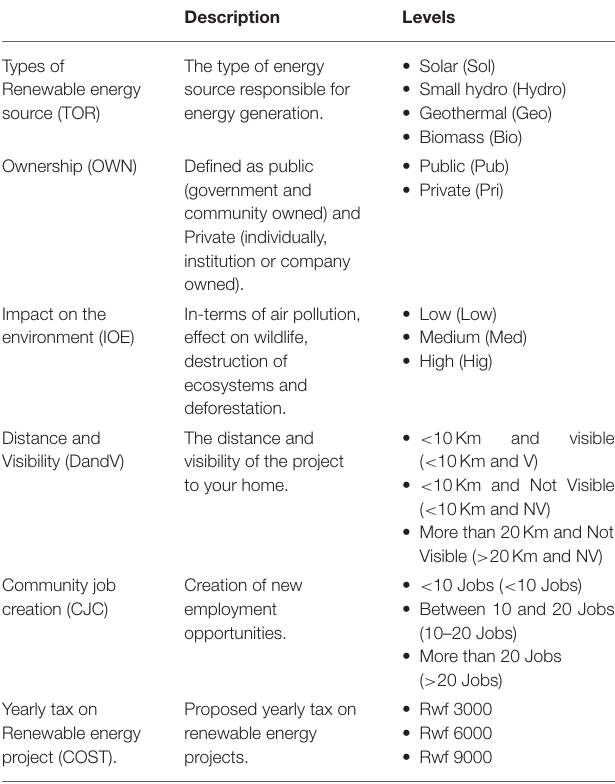
TABLE 2 | Sample choice card including 2 options for renewable energy projects and an opt